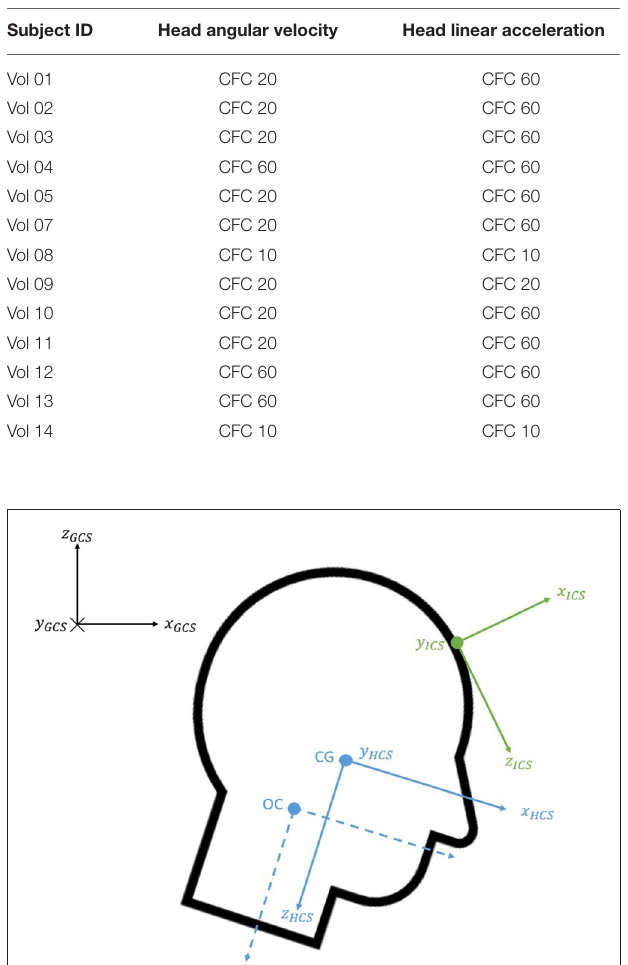
TABLE 2 | Filters and cutoff frequencies used for each test.